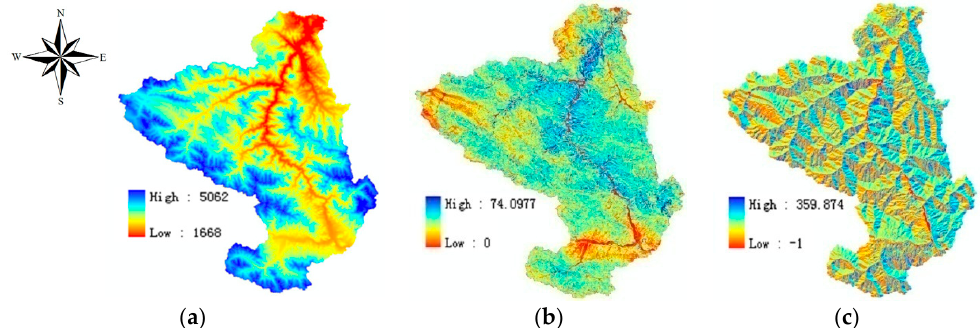
Figure 4. Geographic data of the subbasins: ( a ) Elevation; ( b ) Slope; ( c ) Aspect.